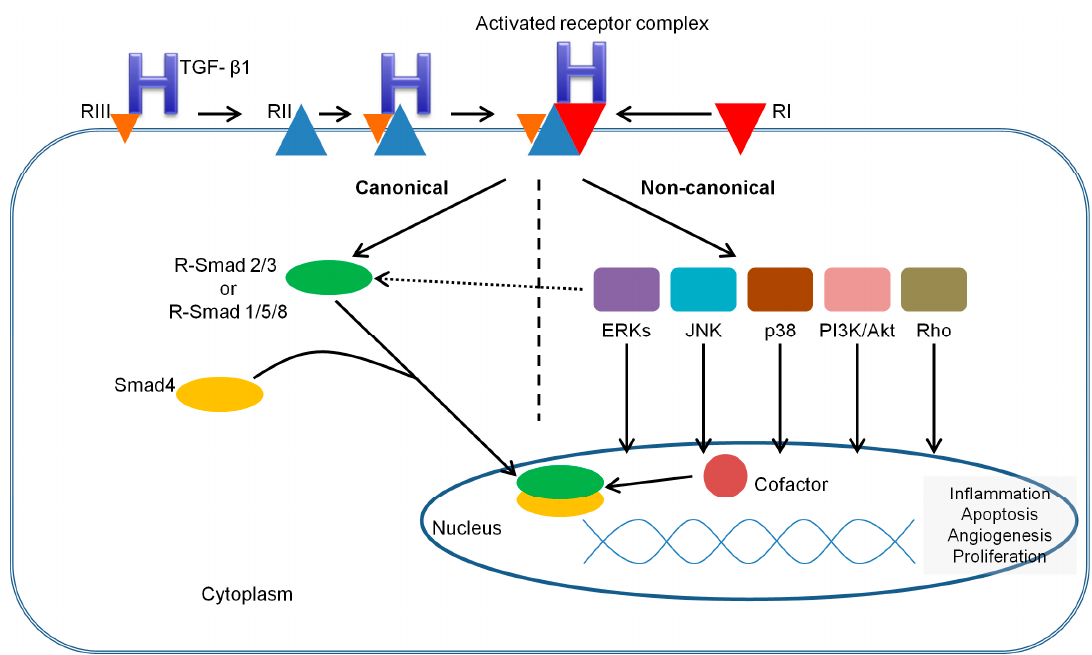
Figure 2. Smad-mediated TGF- β signaling system. Signal transduction by TGF- β 1 is mediated via specific heteromeric complexes of type I and type II receptors. In most cells TGF- β 1 interacts with TGF- β R2 (referred as RII) and ALK5 (referred as RI), but in EC it can also signal via ALK1 (also referred as RI). Coreceptors TGF- β R3 and endoglin (both referred as RIII) can facilitate TGF- β R2/ALK5 and TGF- β R2/ALK1 signaling. Activated receptor complex induces interaction and phosphorylation of R-Smad2/3 [26,53]. Upon phosphorylation, the two activated R-Smads form